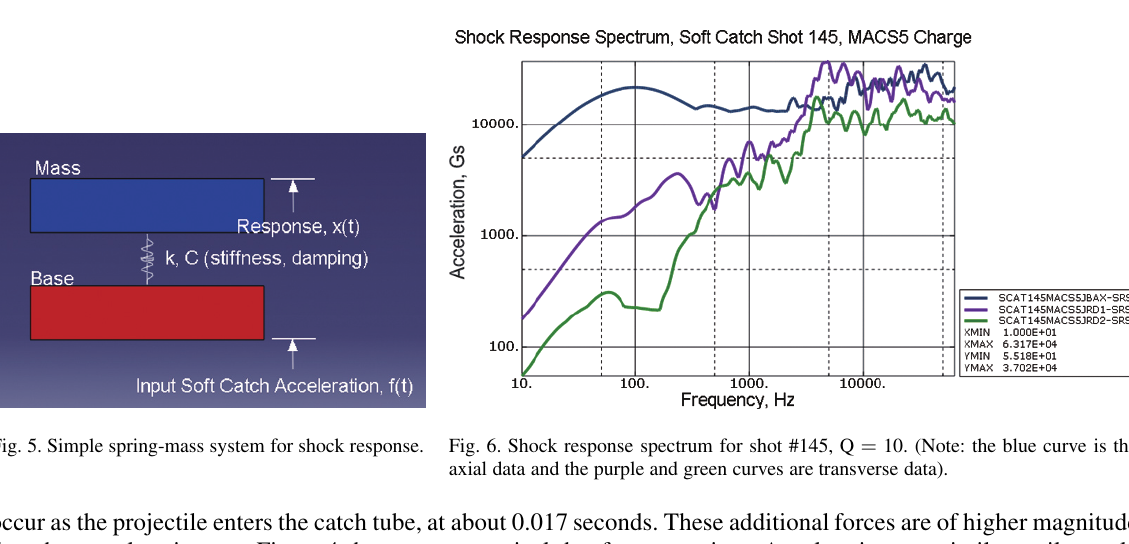
Fig. 3. Acceleration data from a Soft Catch Gun shot (#145). Fig. 4. Acceleration data from a Near-Tactical shot, U.S. MACS 5 Charge.